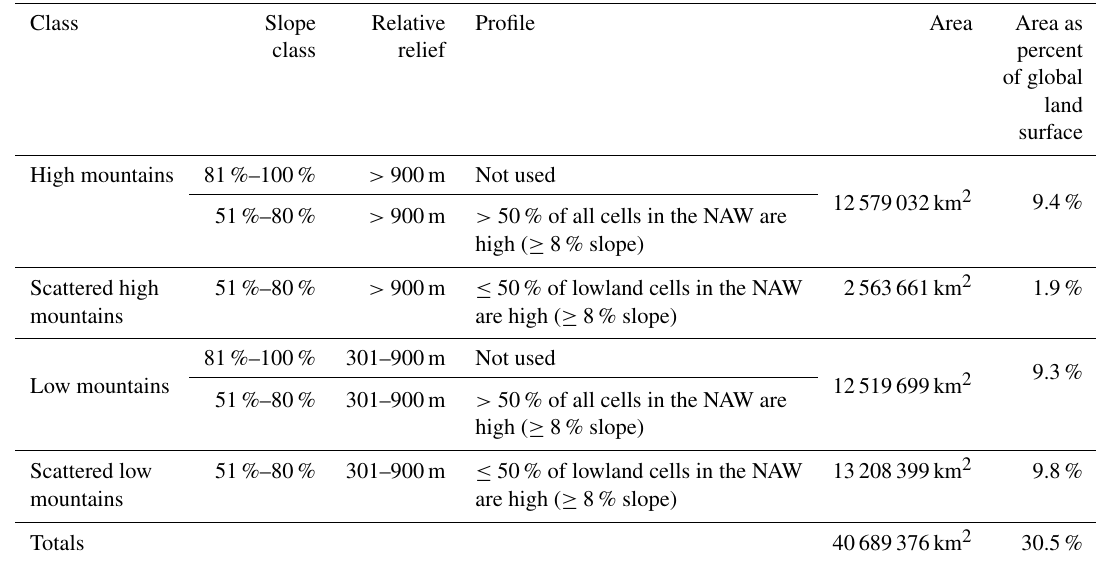
Table A1. The K3 mountain characterisation (Sayre et al., 2018) uses three parameters to characterise the terrain in a 3km moving neigh- bourhood analysis window (NAW). Class Slope Relative Profile Area Area as class relief percent